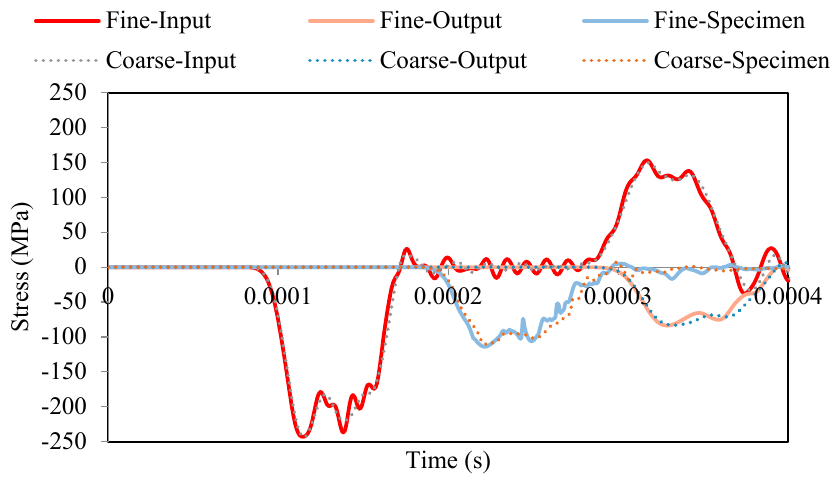
Figure 13. Mesh size sensitivity in a simulation of dynamic compression using SHPB for an initial impact velocity equal to 30 m/s.